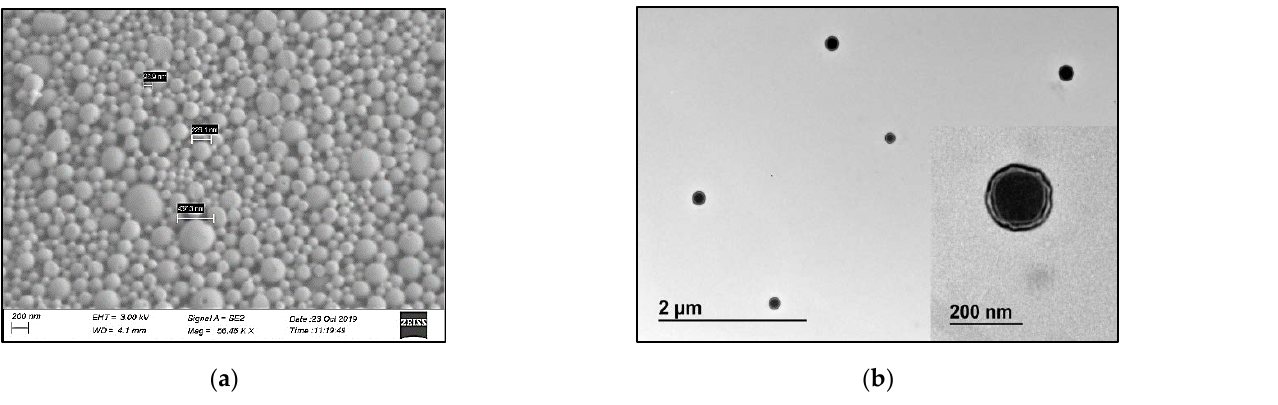
Table 1. Lactobacillus compatibility with the PNP